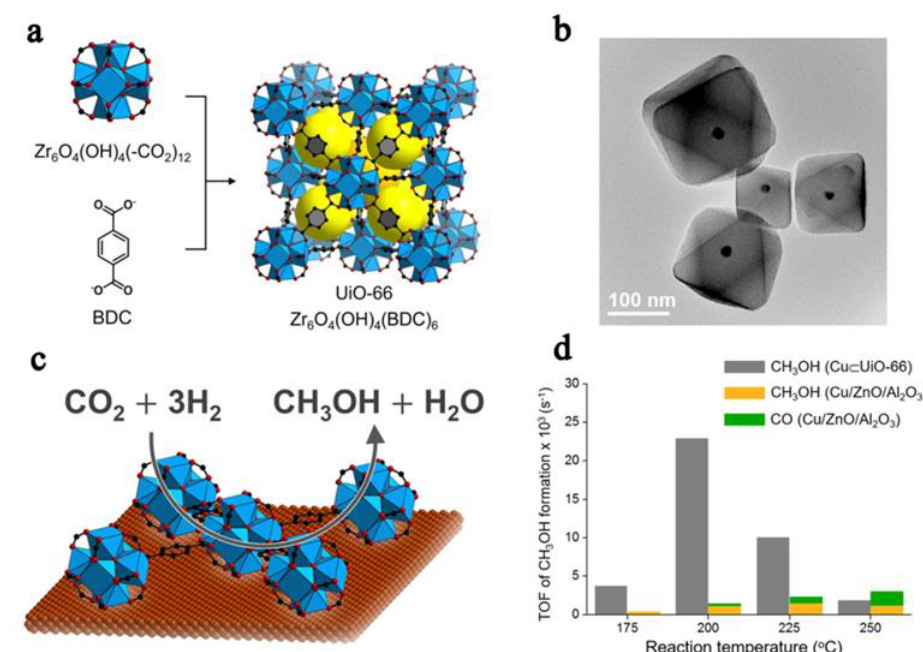
Figure 1. ( a ) Crystal structure of UiO-66; ( b ) TEM images of Cu ⊂ UiO-66 (single Cu NC inside UiO-66); ( c ) Cu NC ⊂ UiO-66 catalyst. Atom labeling scheme: Cu, brown; C, black; O, red; Zr, blue polyhedra. H atoms are omitted for clarity; ( d ) turnover frequencies (TOFs) of product formation over Cu ⊂ UiO-66 catalyst and Cu / ZnO / Al 2 O 3 catalyst at various reaction temperatures